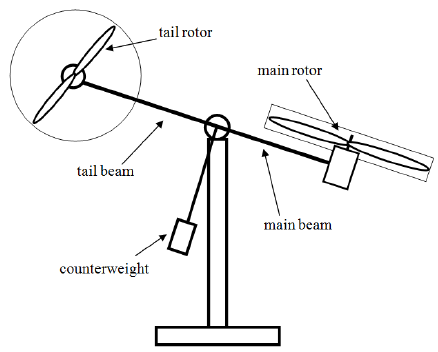
Figure 1. The model of